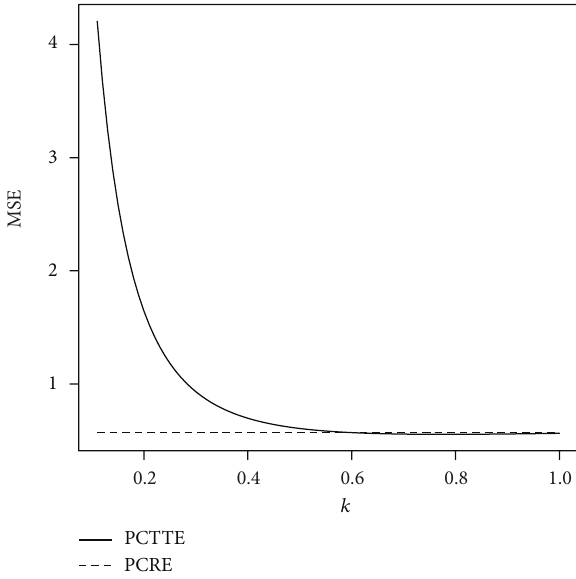
Figure 1: The MSE values of OLSE and PCTTE when 𝑑 = 0.6 .